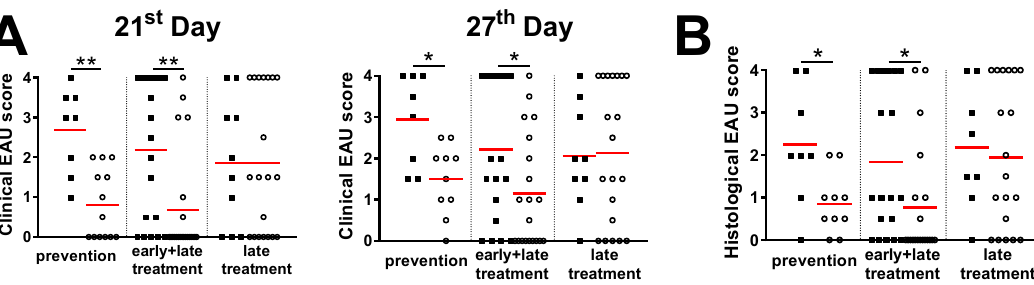
Figure 4. Live EcN decreases severity of EAU if administered at time of disease induction. The EAU severity was analyzed by in vivo fundus biomicroscopy on the 21st and 27th day post-induction ( A ) and by histological analysis at day 28 post-induction ( B ) and the differences were quantified by unpaired Mann–Whitney test; * p < 0.05 ** p < 0.01; n = 8 (placebo prevention), 13 (EcN prevention), 19 (placebo early + late treatment), 22 (EcN early + late treatment), 10 (placebo late treatment) and 20 (EcN late treatment) in total, graphs show individual values and red lines represent mean. Black squares represent individual inflammation severity scores from the placebo group and open circles from the EcN group.